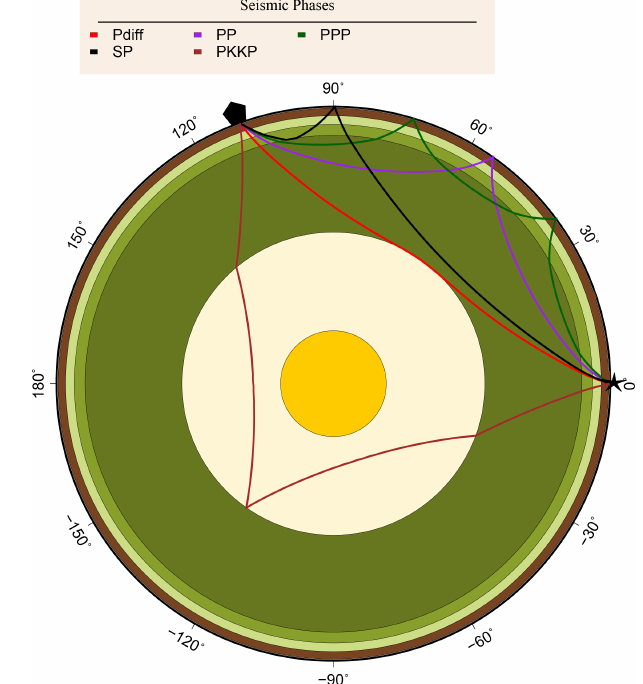
Figure 9. Plot showing some of the ray paths that seismic waves travelled on from the source in Indonesia to the seismic station set up in the WMB tower. The star shows the earthquake epicentre, while the pentagon denotes the station location. The inner core is shown in yellow, the outer core in beige, and the mantle in green and brown in the image. The thin crust on which we live is the black outer layer, which is barely visible in the image. The arrivals of these phases are marked on the seismogram in Fig.